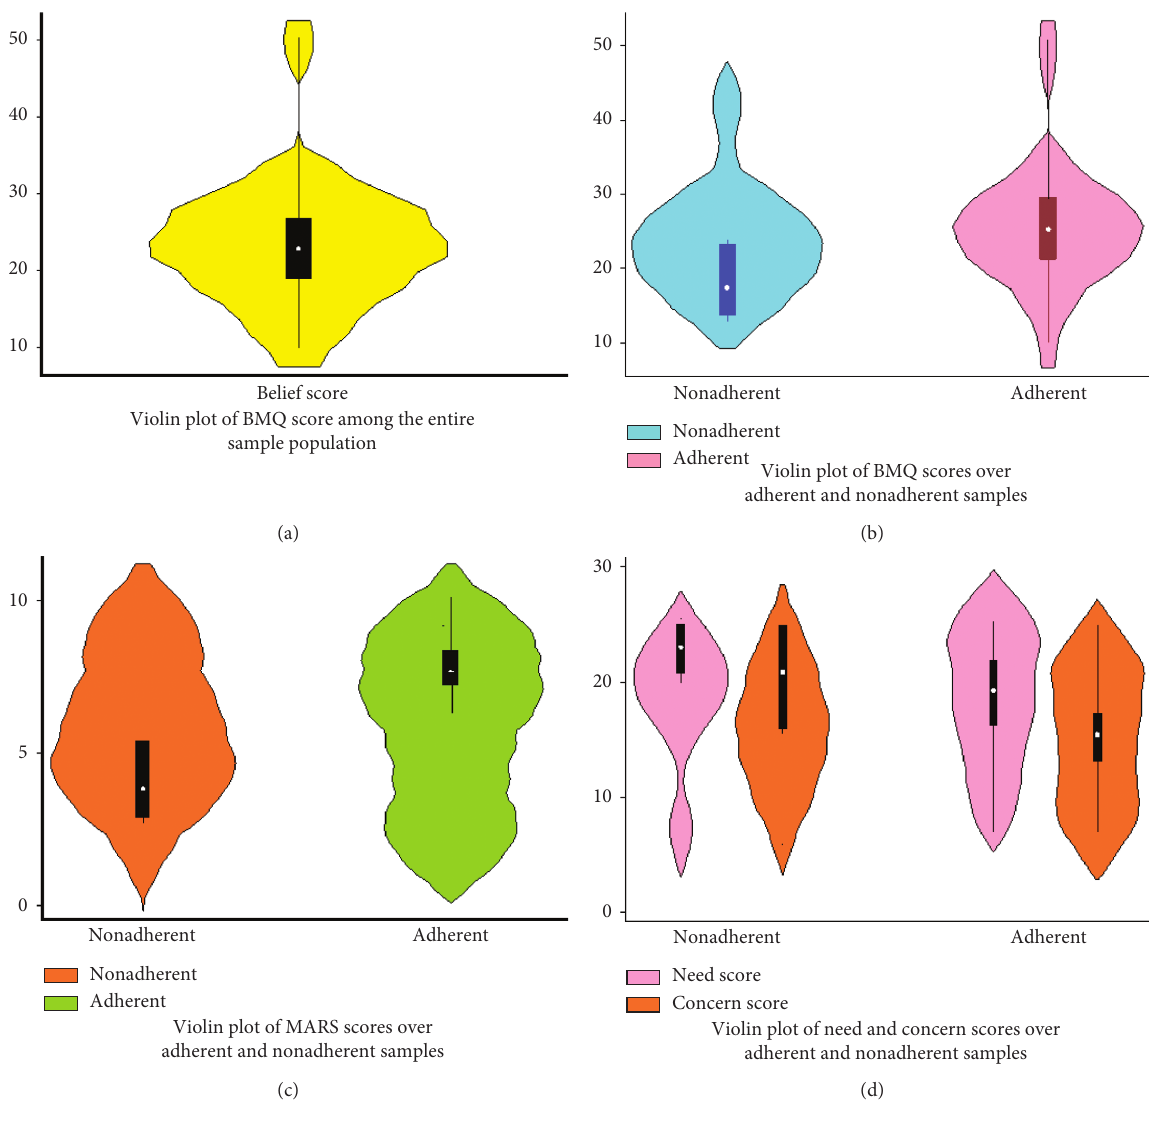
Figure 1: Violin plots summarizing various data points among elderly subjects with